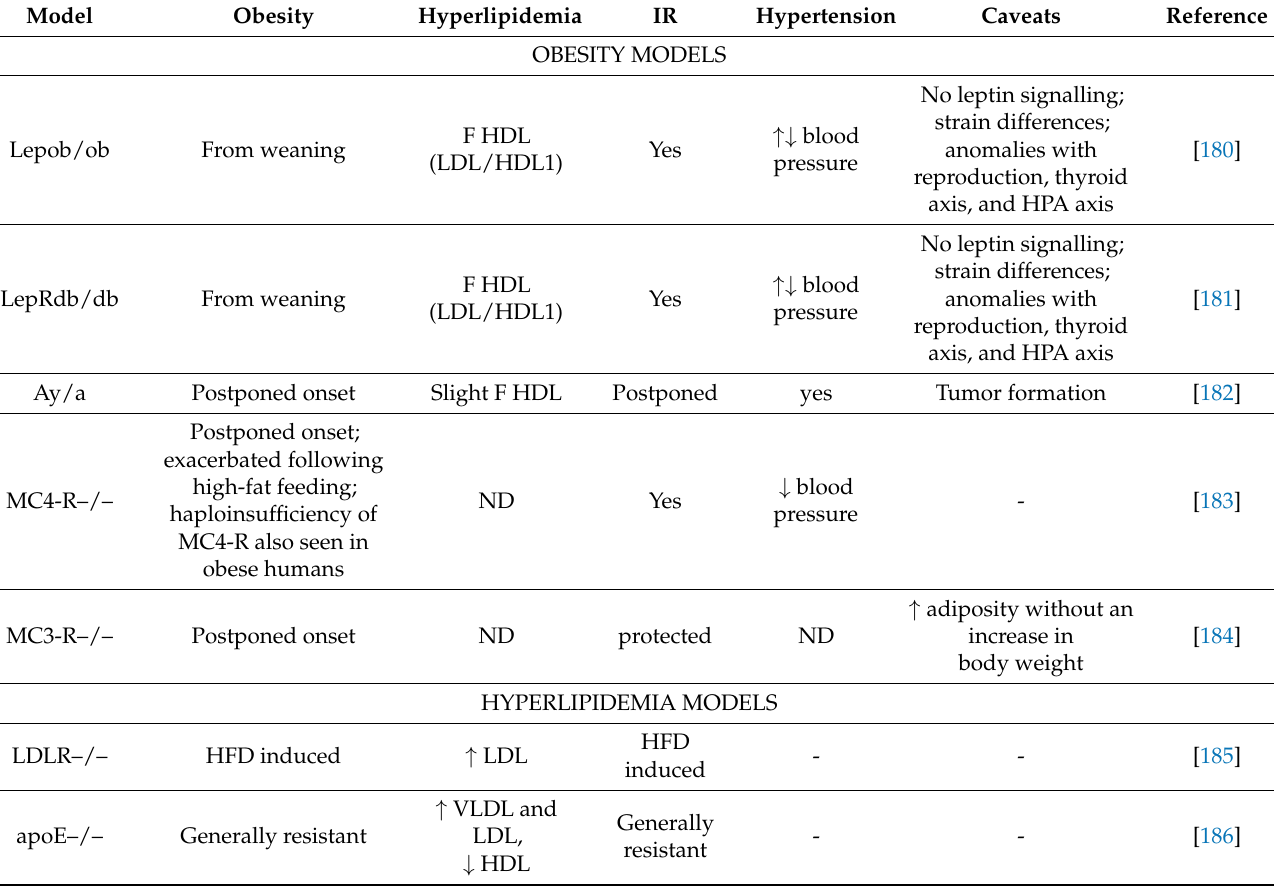
Table 4. Latest studies revolving around MetS in mice. ↑ signifies increase. ↓ signifies